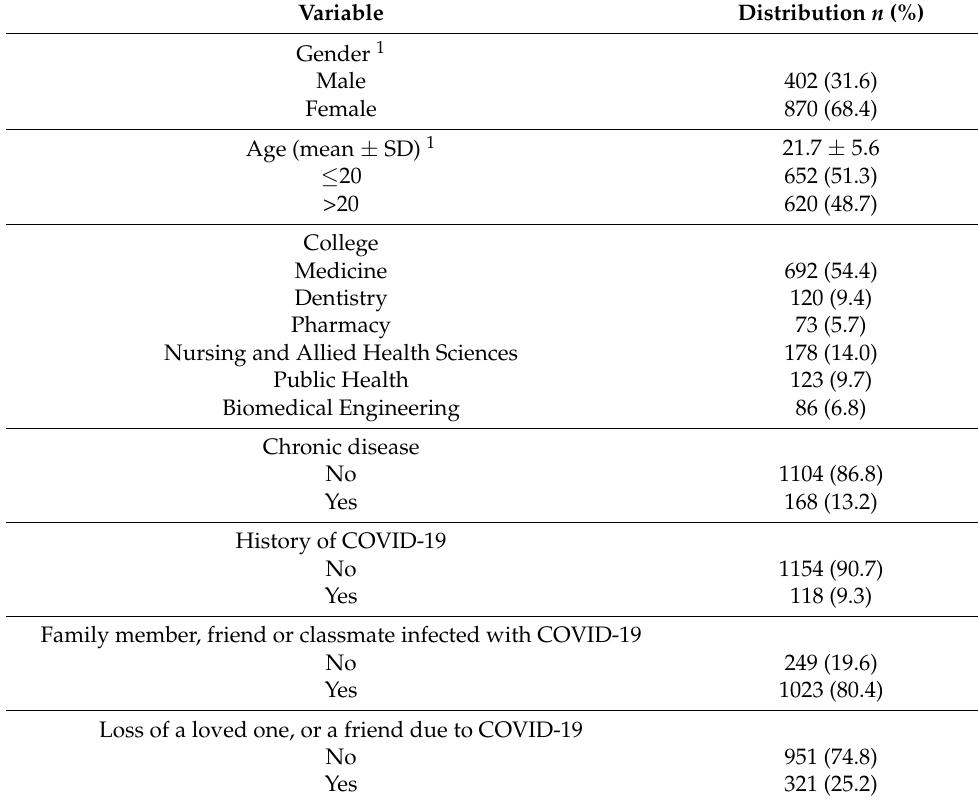
Table 1. Sociodemographic and health history characteristics of participants ( n =